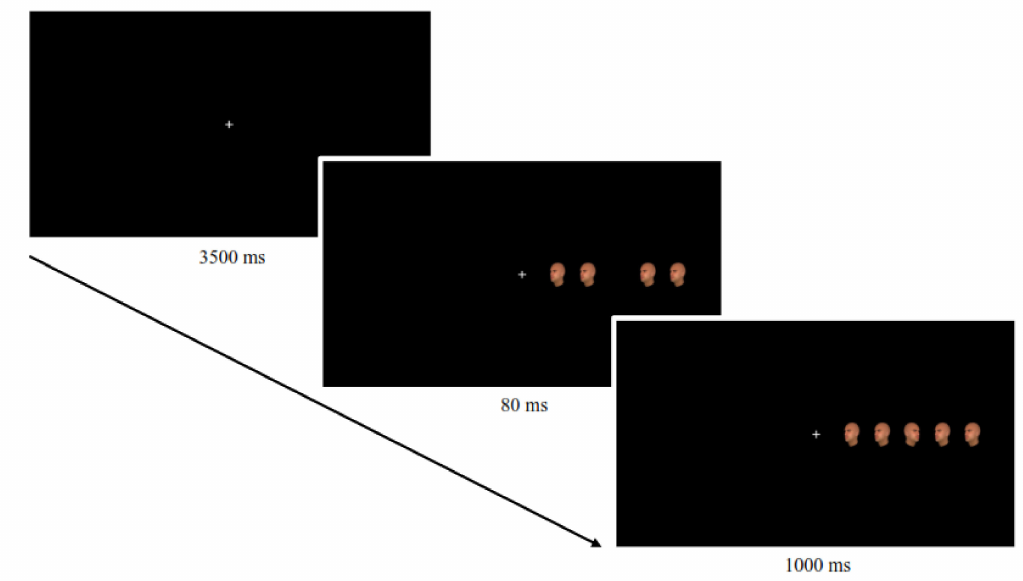
Figure 1. Exemplary trial of the Flanker task. Each unique trial consisted of a fixation cross, followed by the presentation of four flanker faces shown for 80 ms before the identical target face appeared in the center. Participants indicated the viewpoint direction of the target face via keystroke. Half of the 224 trials were congruent (i.e., identical viewpoint direction of flankers and target face), the other half were incongruent (as shown here). Proportion of conflict frequency was manipulated according to context depending on stimulus location: one side of the fixation cross was associated with 75% congruent trials (low conflict condition), the other side with 75% incongruent trials (high conflict condition). Which side of the fixation featured which condition was balanced across